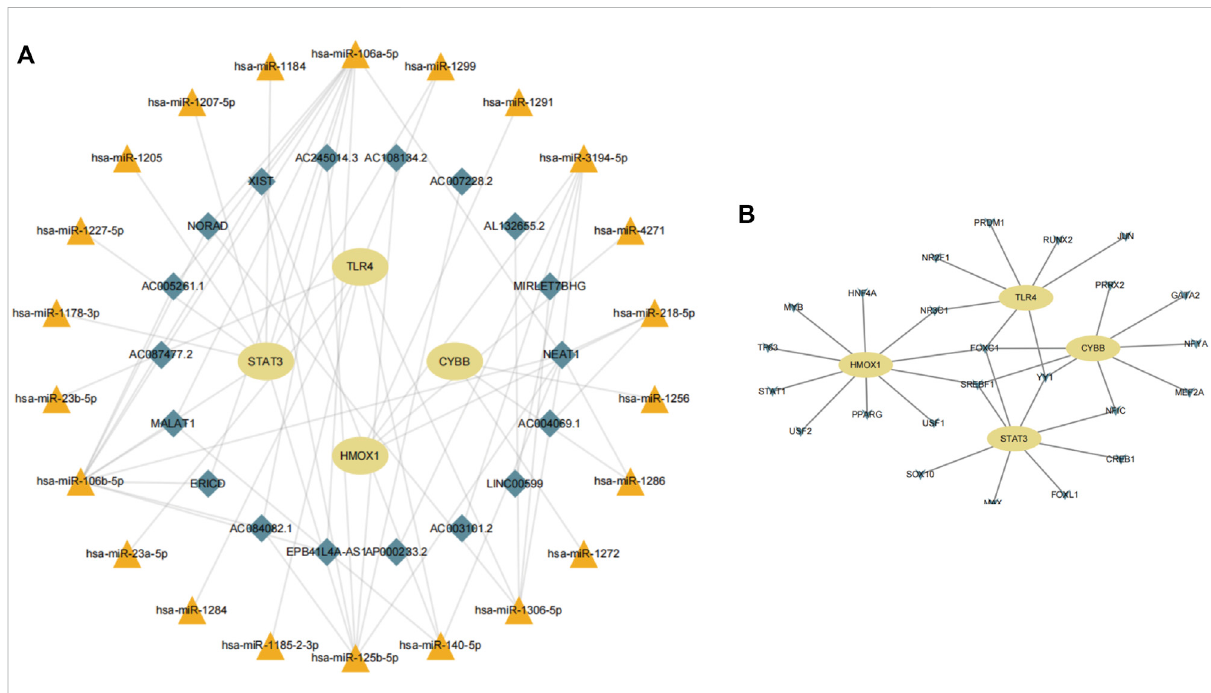
FIGURE 9 (A) Construction of a gene-miRNA-lncRNA interaction network. (B) Identi fi cation of potential